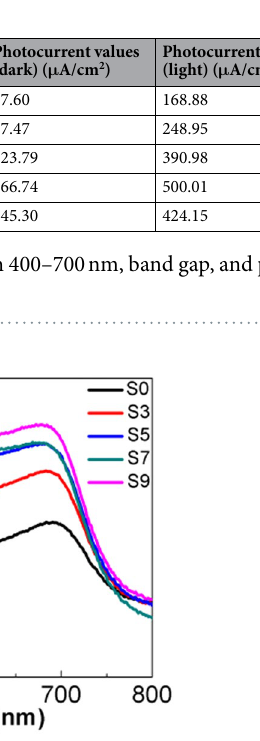
Figure 5. UV-Visible absorption spectra of Cu x O/TiO 2 prepared with different SILAR cycles.